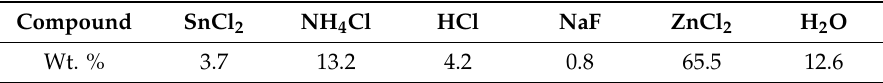
Table 3. Chemical composition of the flux.